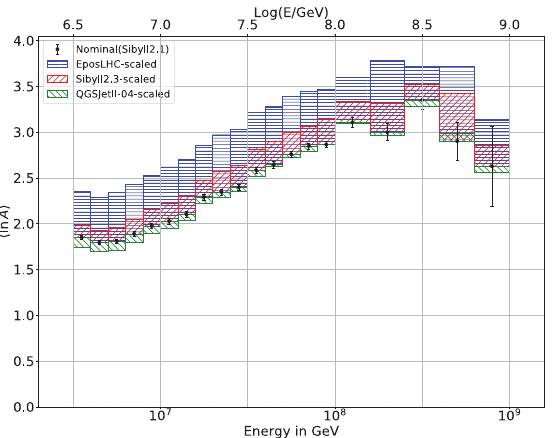
Figure 8: Hadronic interaction model uncertainty range on (cid:4) ln A (cid:5) relative to the base model for Epos-LHC [9] (blue), Sibyll2.3 [10] (red) and QGSJetII-04 [11] (green) [5].